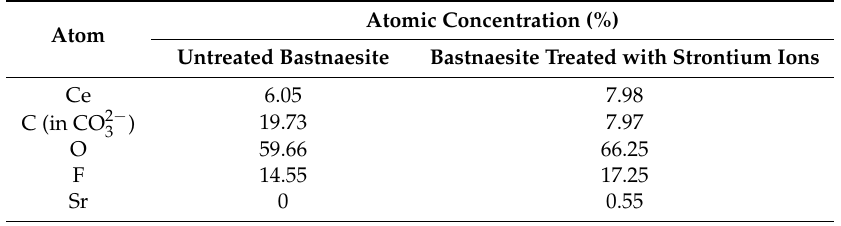
Table 1. Atomic concentrations of bastnaesite samples before and after strontium ion treatment. Atomic Concentration (%) Atom Untreated